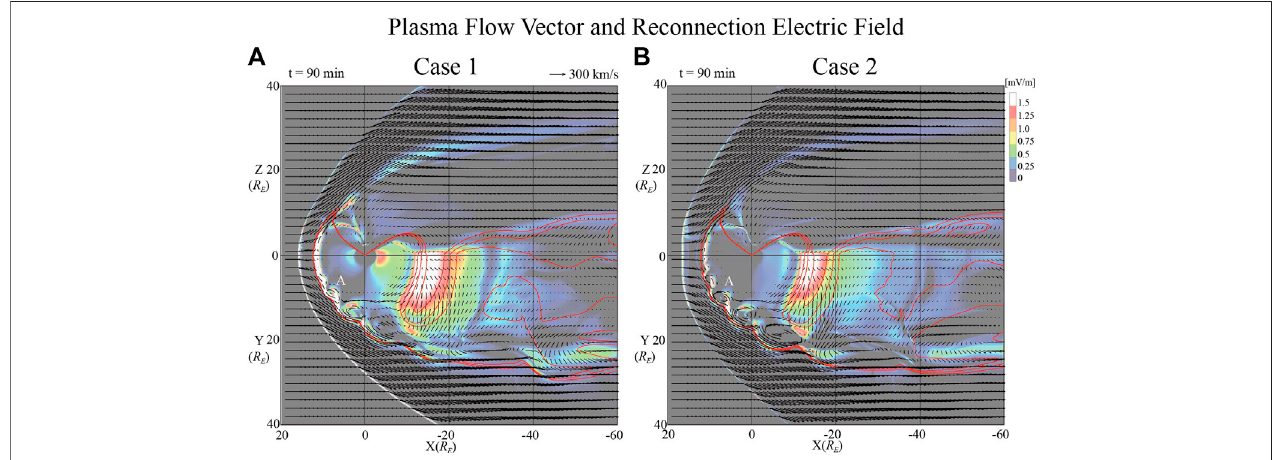
FIGURE3| Theplasma fl owvectorsinthe XZ (top) and XY planes (bottom) attimet (cid:1) 90 mininsimulationduringtheweaksouthwardconditioninCase1 (A) and in Case 2 (B) . The red lines are contours of the B z (cid:1) 0 region. The color contour is convection electric fi eld.